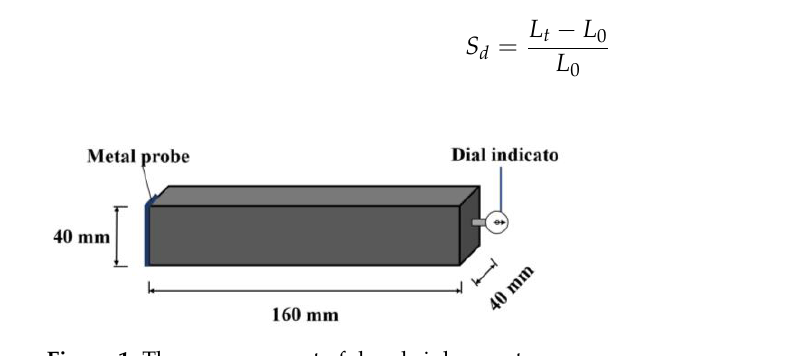
Figure 1. The measurement of dry shrinkage rate.